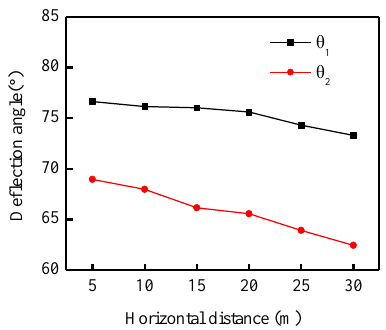
Figure 16. Relationship between initiation location and two deflection angles ( θ 1 and θ 2 corresponding to quarter-length (10 m) and the half-length (20 m) deflection angle, respectively).